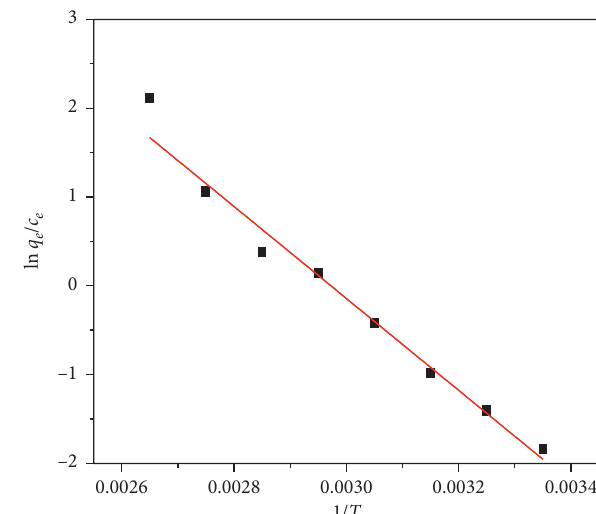
Figure 14: Thermodynamic parameters for the adsorption of dye onto